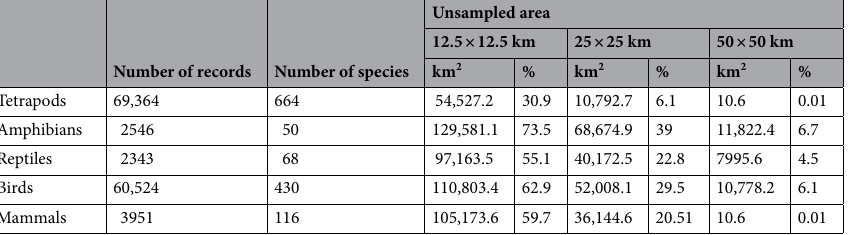
Table 1. Occurrence records and unsampled area (grids without records) per tetrapod group. Number of records (non-duplicated records/location/year), number of species and unsampled area (expressed in km 2 and percentage of the total area of Uruguay), for all tetrapods and separated classes, according to each grid-cell size (12.5 × 12.5 km, 25 × 25 km and 50 × 50